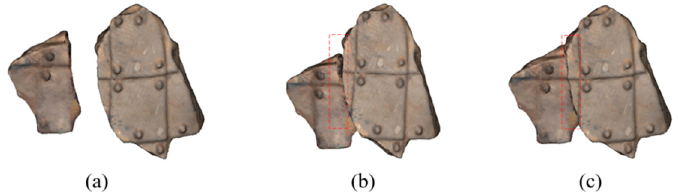
Figure 15. Reassembly results in partially similar conditions. ( a ) Two fragments; ( b ) the reassembly result of our SPPD method; ( c ) ground truth.